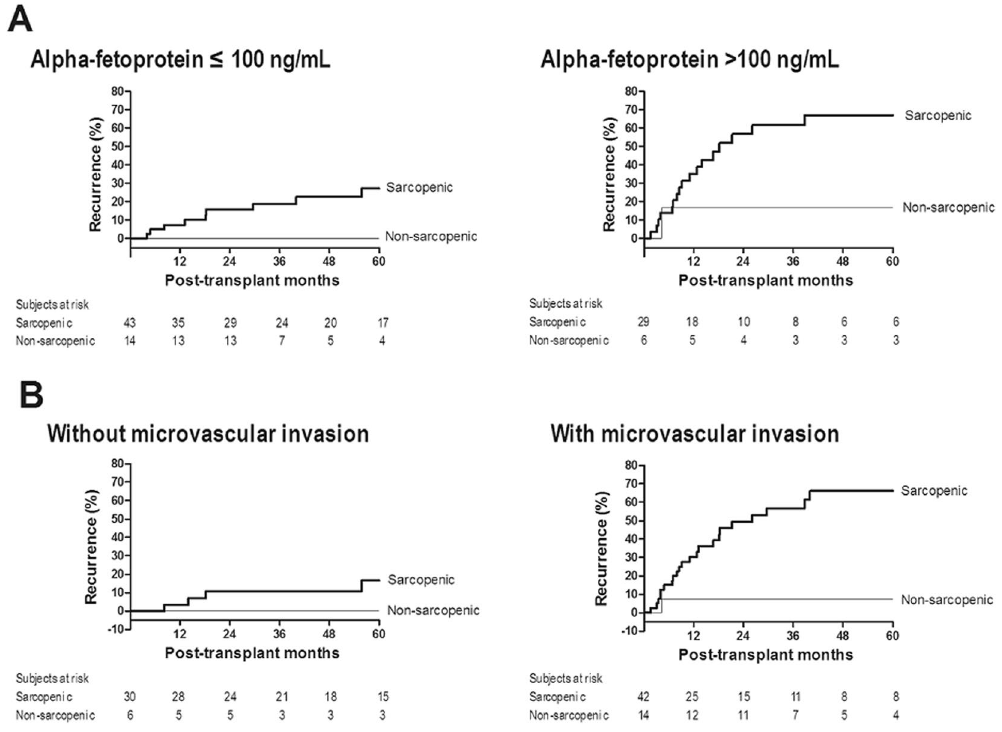
Figure 3. Cumulative recurrence probability according to the presence of sarcopenia in subgroups stratified by ( A ) alpha-fetoprotein level and ( B ) tumor microvascular